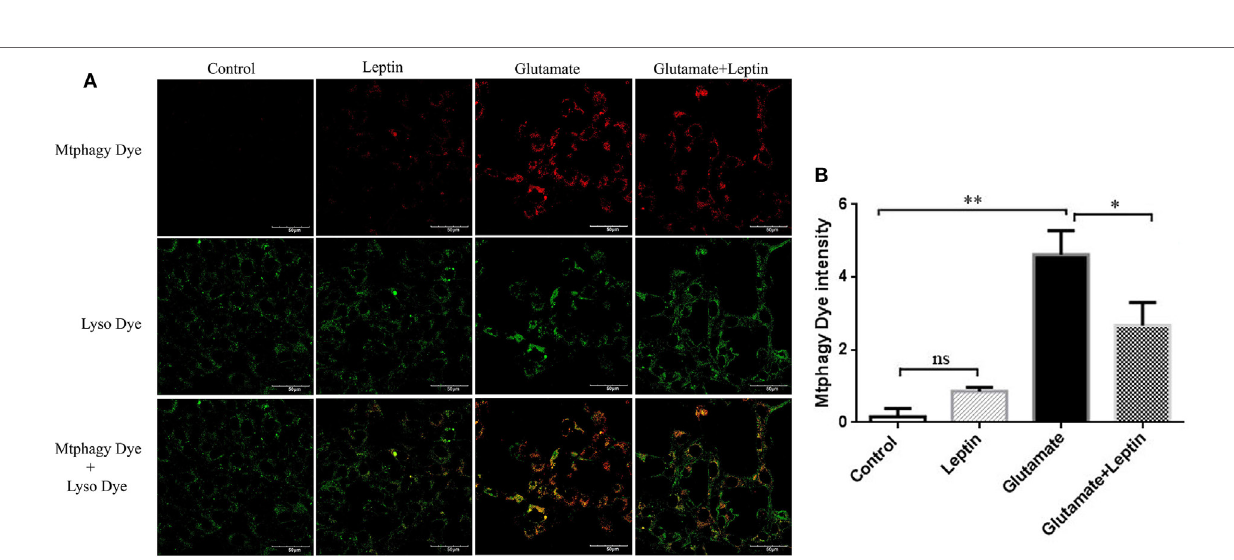
FigUre 4 | Leptin reduces mitochondrial reactive oxygen species (ROS) accumulation. (a) The fluorescence intensity of mitochondrial ROS in HT22 cells; (B) the quantitative analysis of average fluorescence intensity of mitochondrial ROS. * P < 0.05, ** P < 0.01. ns, not